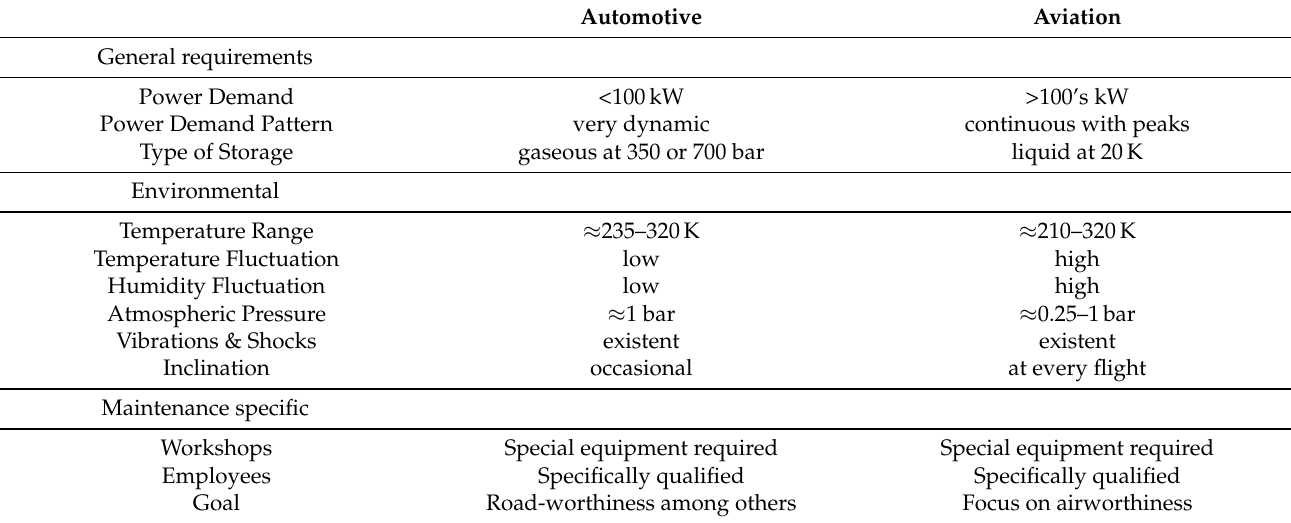
Table 2. Summary of commonalities and differences in fuel-cell applications in the automotive and avia- tion